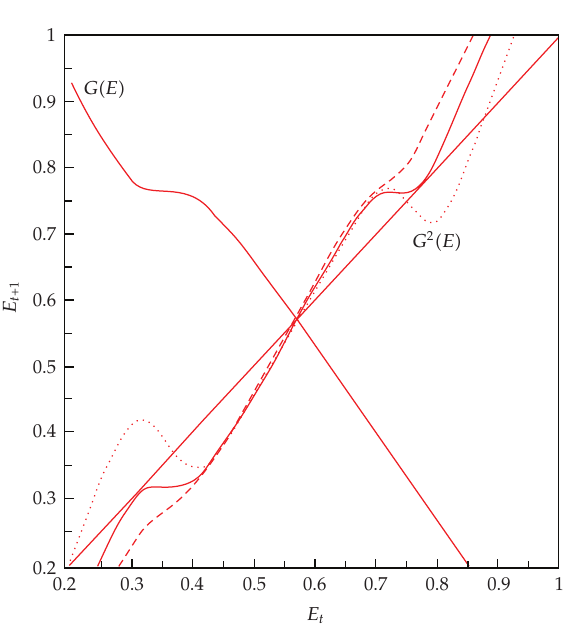
Figure 5: Evolution of the second iterate (cid:5) G is drawn at the bifurcation value A (cid:8) 0.132 (cid:6) .